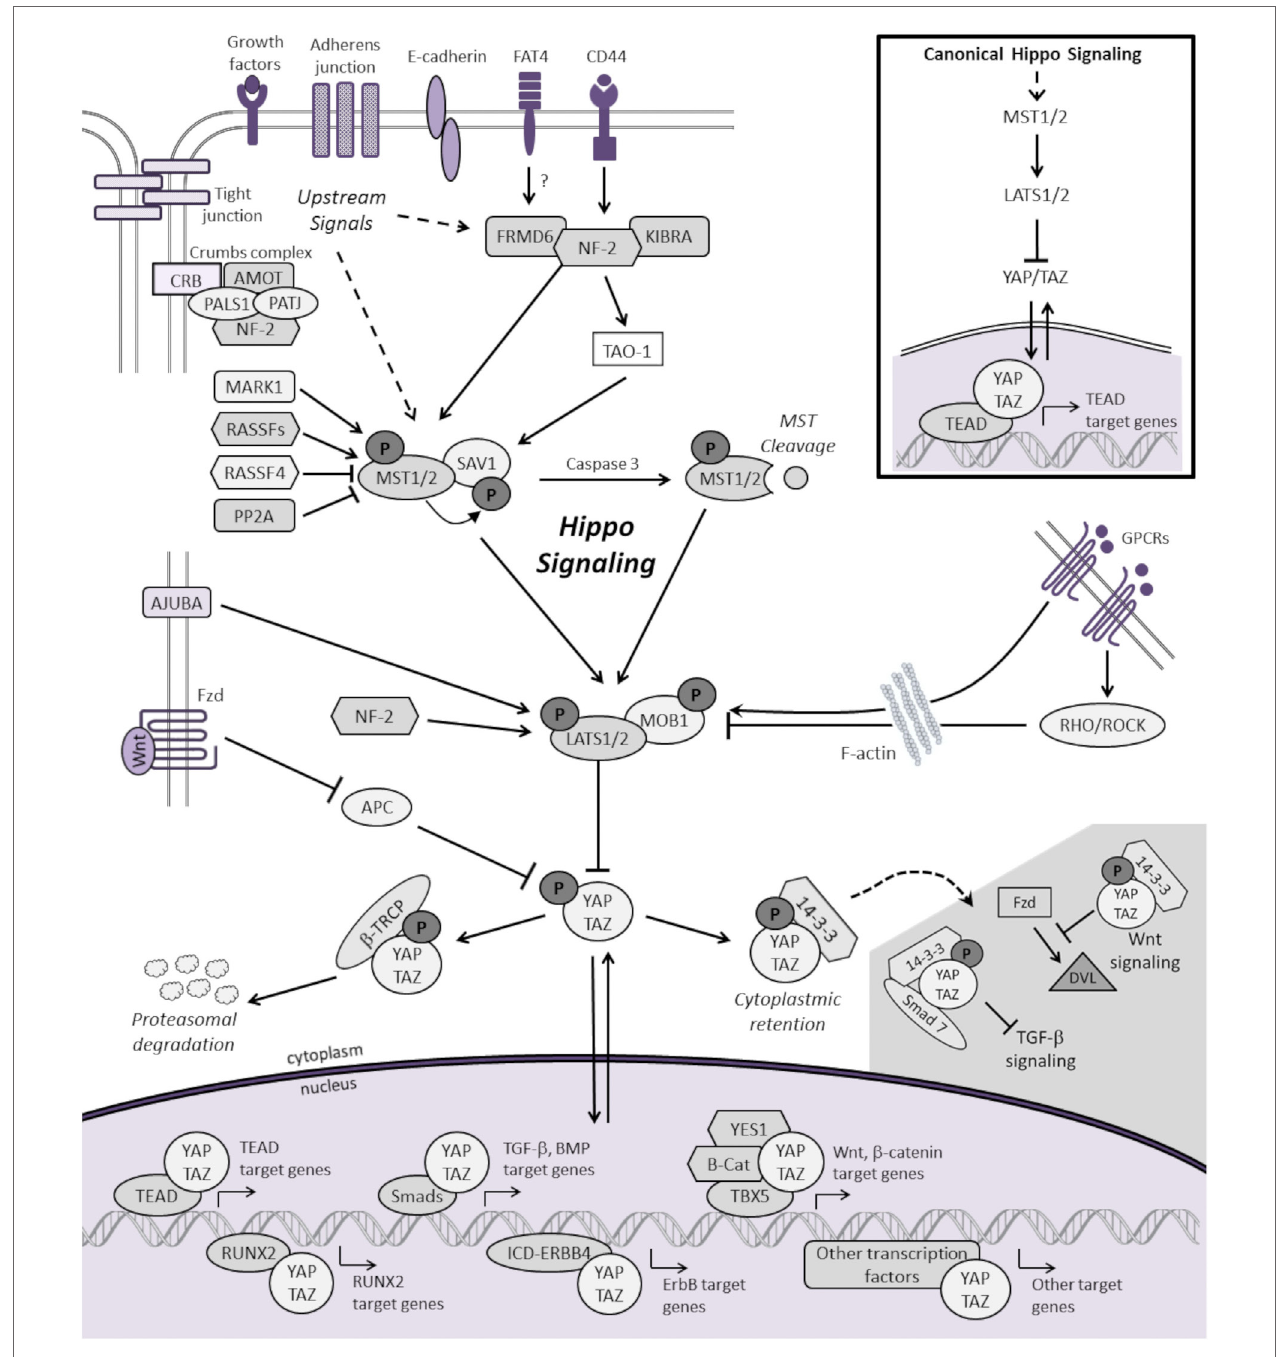
cytoskeleton. For simplicity, not all the known protein–protein interactions and regulators of Hippo signaling are represented. When Hippo signaling is “OFF”, YAP/TAZ translocate to the nucleus to serve as transcriptional co-activators for TEADs as well as other transcription factors (only a few of which are represented here) involved in cellular proliferation, differentiation, self-renewal, and apoptosis. See text for additional